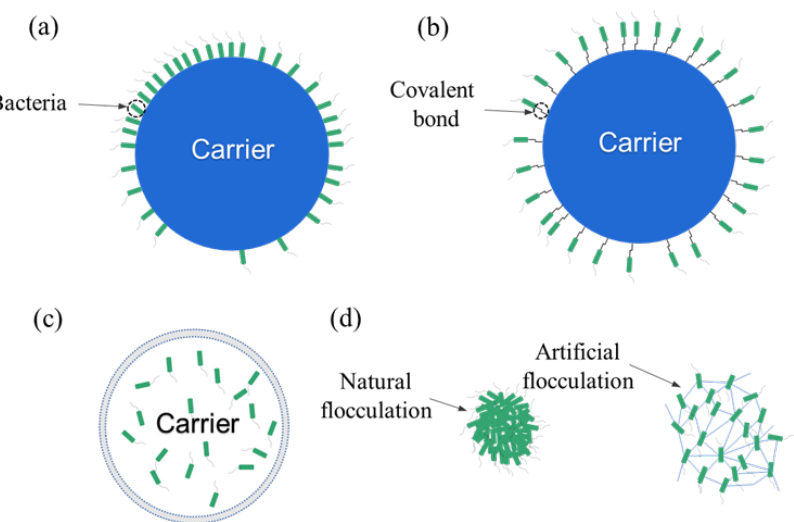
Figure 2. Microbial immobilization methods: ( a ) Adsorption; ( b ) Covalent binding; ( c ) Encapsulation; ( d ) Flocculation.